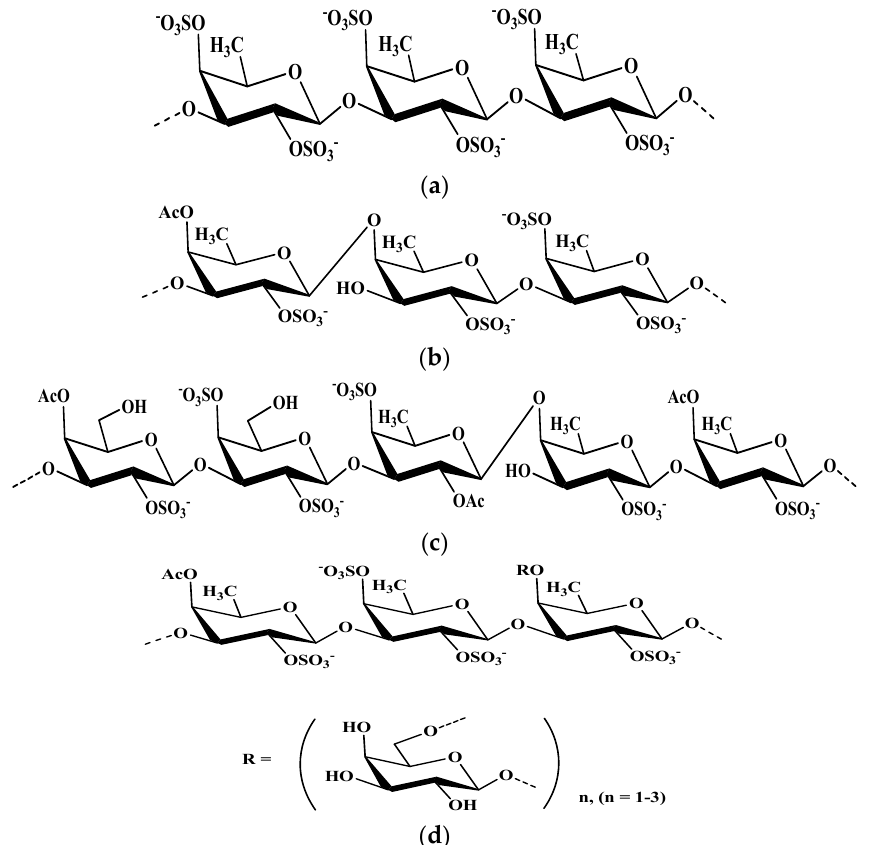
Figure 2. Structural fragments of fucoidans. ( a ) I structural group. ( b ) II structural group. ( c , d ) III structural group.